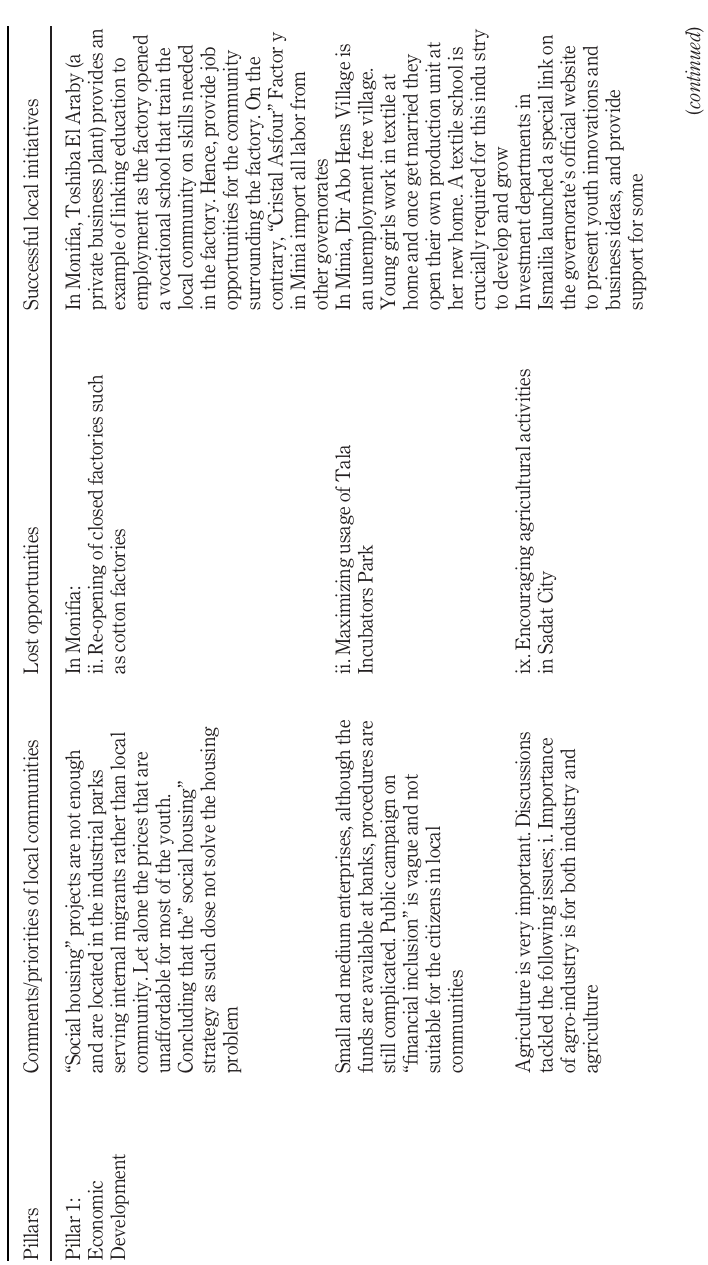
Table AI. Reflection of the FGDs on the ten pillars of “ Egypt vision 2030